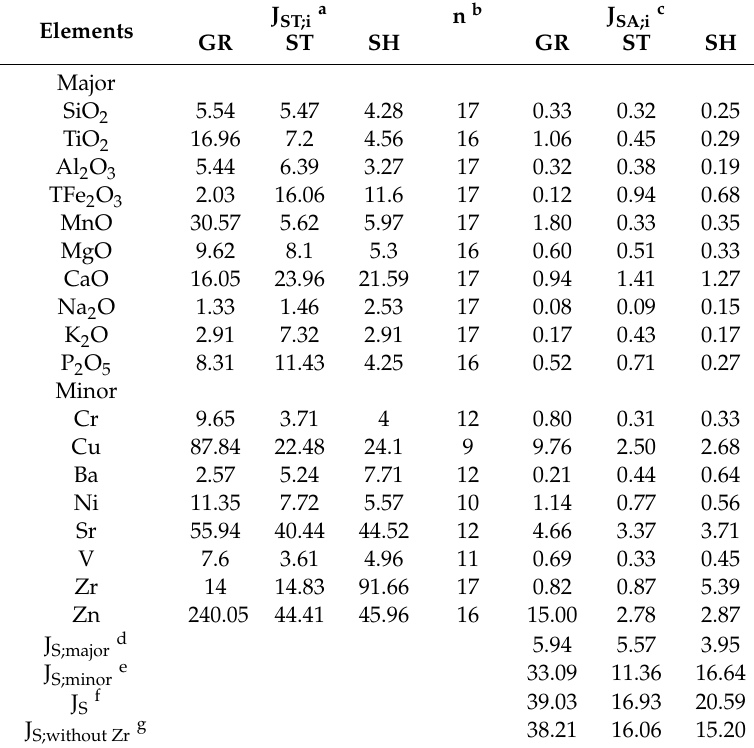
Table 5. Weighted discrepancies between the measured and recommended values of 19 reference materials obtained by the three di ff erent sample preparation procedures and analyzed by wavelength dispersive X-ray fluorescence spectrometry